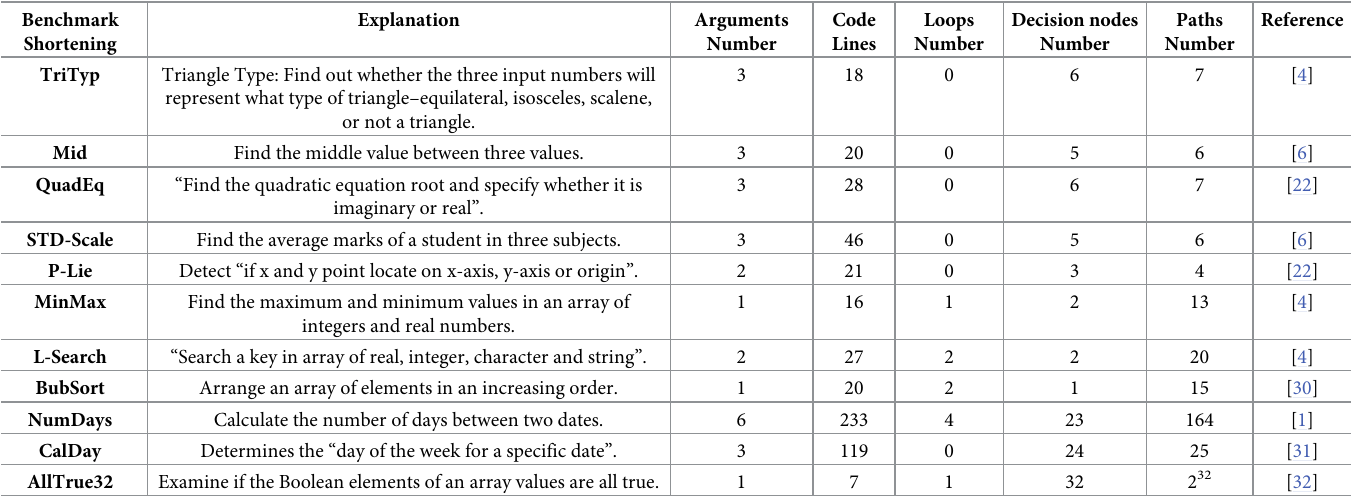
Table 1. The benchmark programs description.